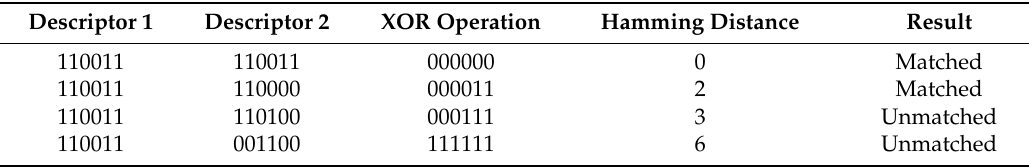
Table 1. Matching process (Note: the length of a BRIEF descriptor is assumed 6, and the threshold (t) is given